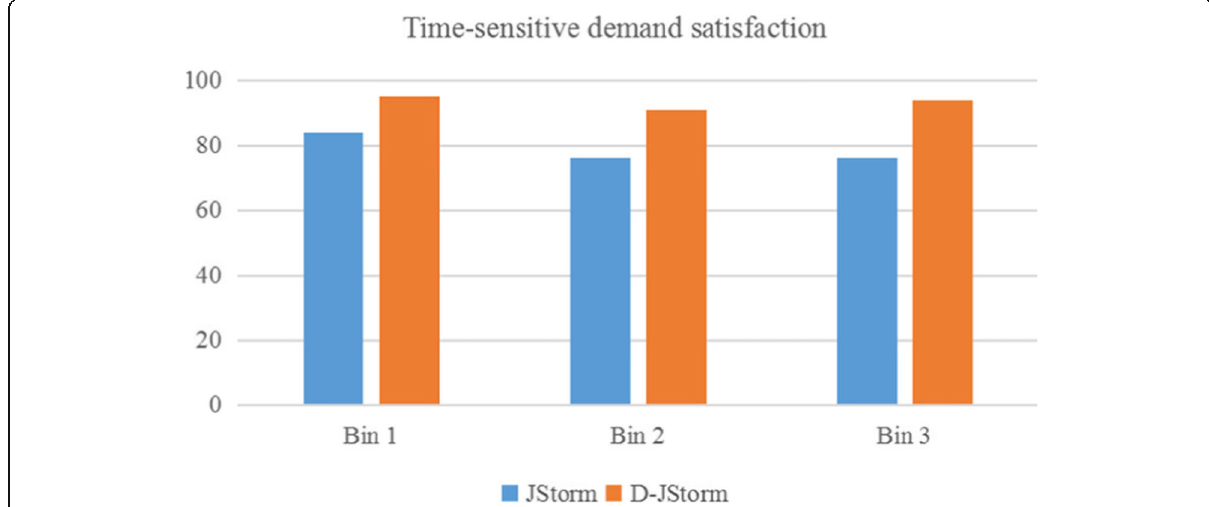
Fig. 1 Comparison of the satisfaction of time-dependent demand under different data arrival strengths